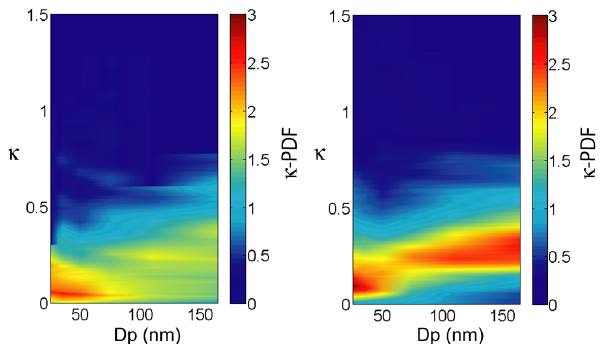
Figure 2b. Yearly average κ -PDFs as a function of particle diame- ter, measured at RH90, for measurement years 2011 (left panel) and 2012 (right panel).